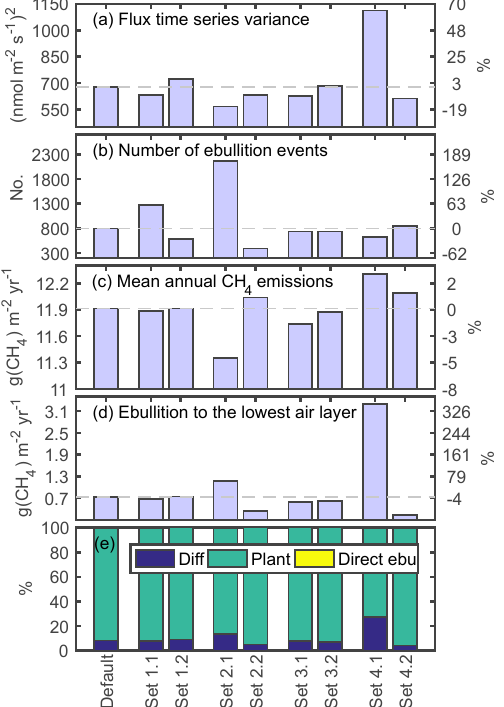
Figure 6. Results from the EBG sensitivity analysis (see parameter values in Table 1): variance in the CH 4 flux time series ( a ), total number of ebullition events (b) , mean annual CH 4 emissions (c) , mean annual ebullition flux to the lowest air layer (d) and the aver- age contribution of different emission pathways to the overall CH 4 flux to the atmosphere (e) . Direct ebullition to the surface is negli- gible on an annual scale and hence not visible in panel (e) . Absolute values are on the y axis on the left, and change relative to the de- fault run is on the right side. Grey dashed lines highlight the values obtained with the default